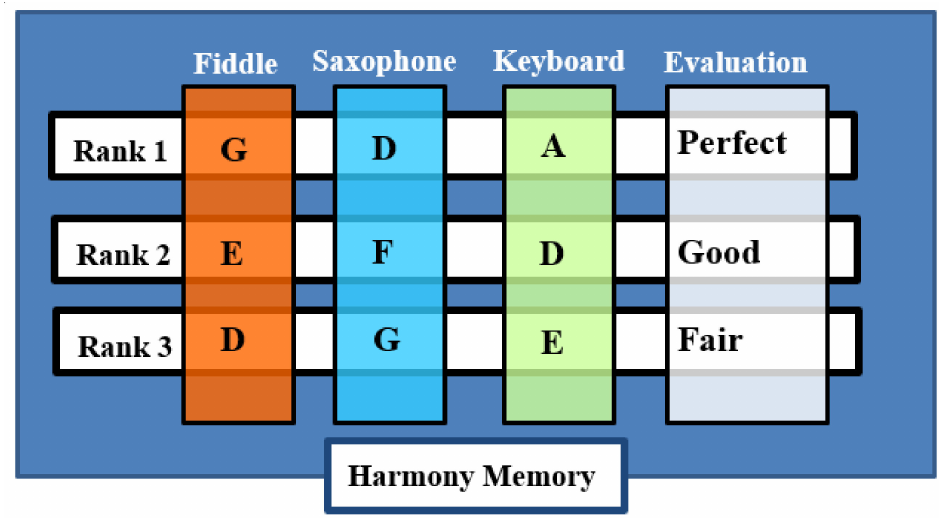
Figure 3. The pattern of Harmony